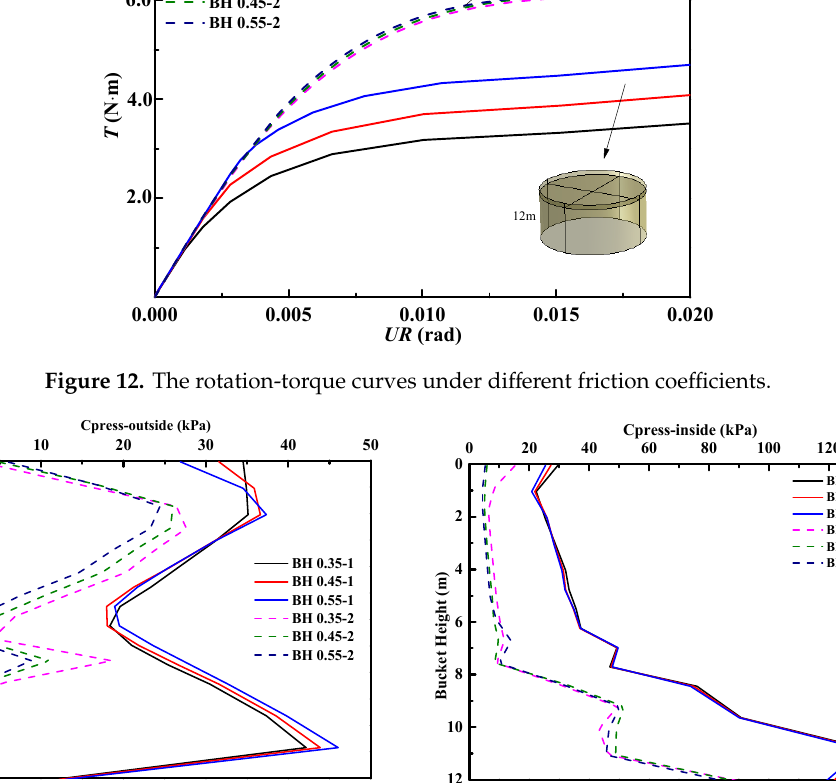
Figure 12. The rotation-torque curves under different friction coefficients.